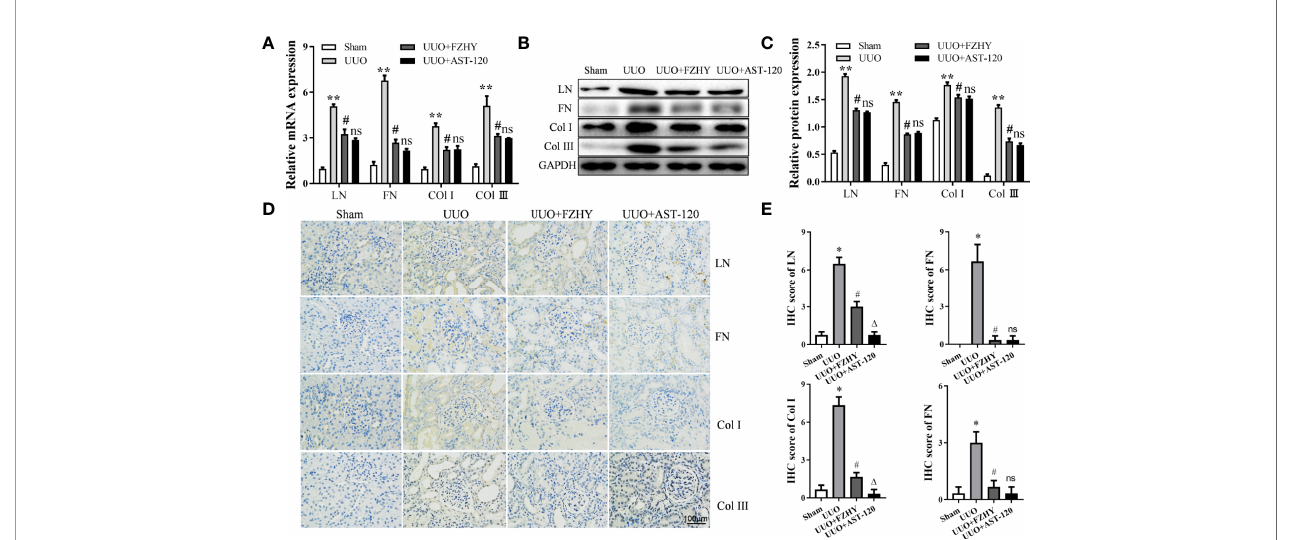
FIGURE 8 | Effect of FZHY on renal interstitial fi brosis in UUO rats. The mRNA (A) and protein (B, C) levels of the renal interstitial fi brosis proteins LN, FN, Col-I, and Col- III were evaluated in the sham, UUO, UUO+FZHY, and UUO+AST-120 groups on day 7. The immunohistochemistry of LN, FN, Col-I, and Col-III (D, E) from kidney sections was analyzed. * P < 0.05, ** P < 0.01, the UUO group vs. the sham group; # P < 0.05, the UUO+FZHY group vs. the UUO group. ns, not signi fi cant.